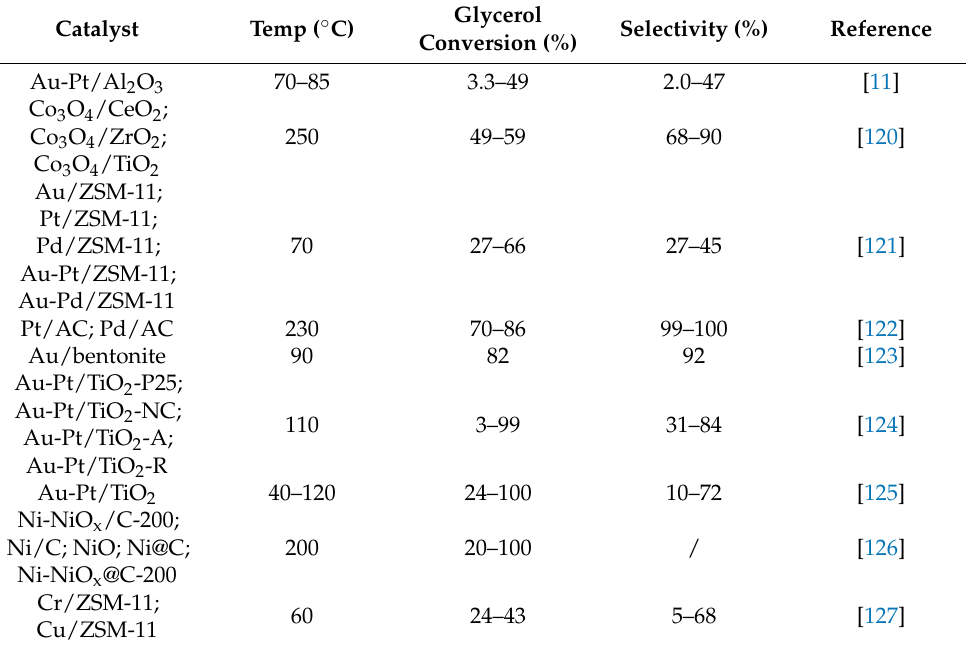
Table 5. A summary of recent studies on glycerol oxidation to produce lactic